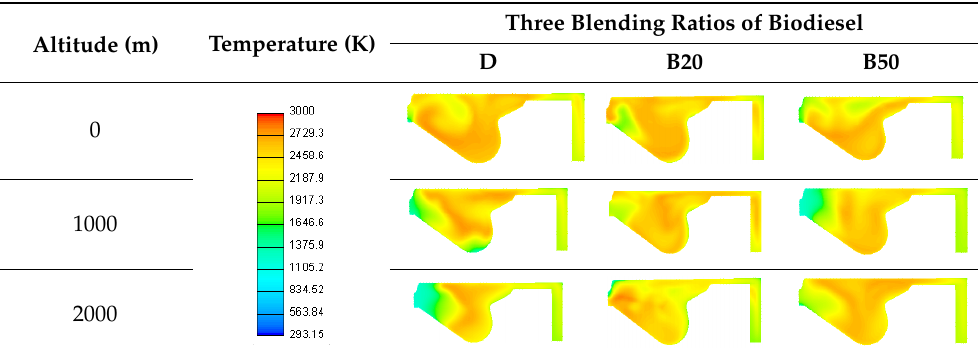
Table 2. Effect of different plateau environments on temperature field of cylinder with three blending ratios.